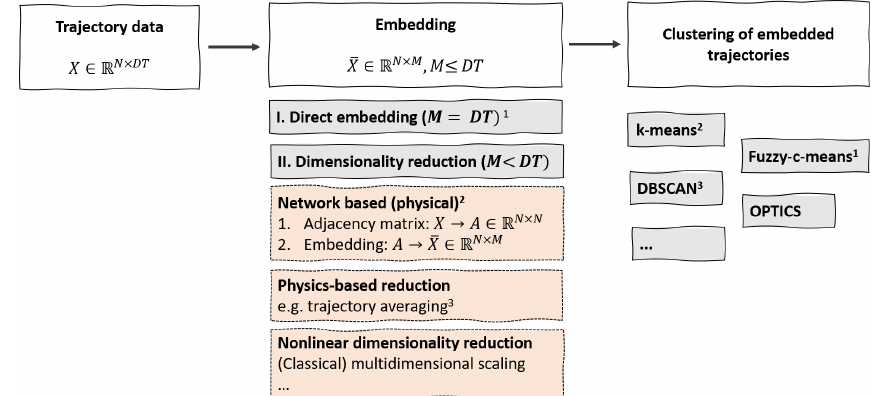
Figure 1. Different steps for detecting coherent trajectories in Lagrangian data with trajectory clustering. The figure is nonexhaustive, and many more options for embedding and clustering exist. Footnotes: 1 Froyland and Padberg-Gehle (2015). 2 Hadjighasem et al. (2016), Padberg-Gehle and Schneide (2017) and Banisch and Koltai (2017) all define networks with spectral embedding and subsequent k -means clustering. Froyland et al. (2019) define spectral embeddings as being on dynamic Laplacian and transfer operators. 3 Schneide et al.